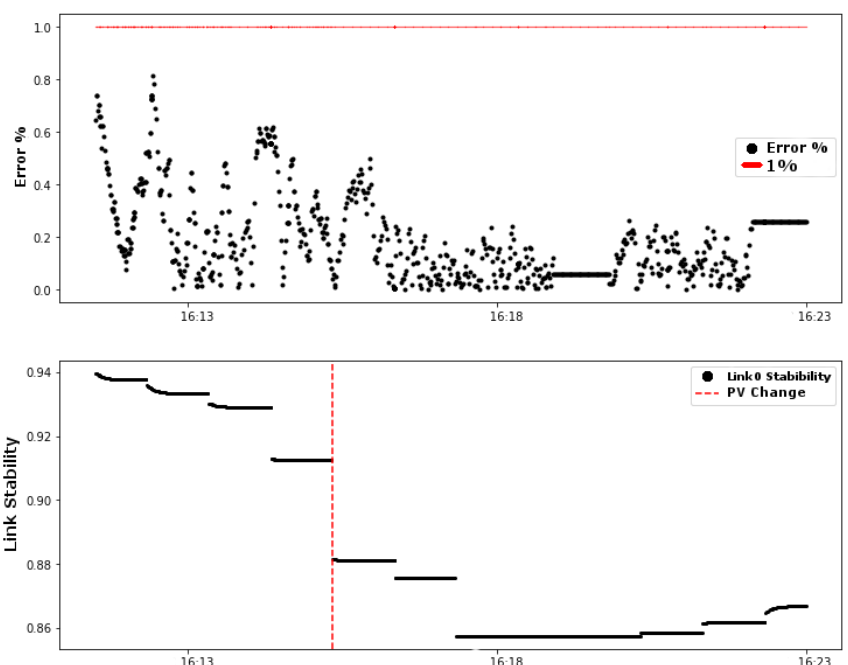
Figure 15. Results of the control system based on link stability: error (%) and link